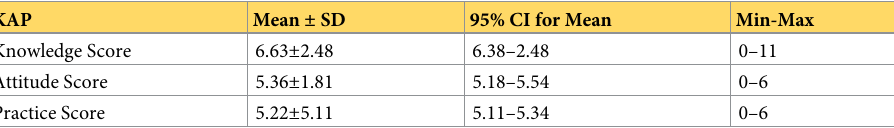
Table 2. Mean KAP score of women toward